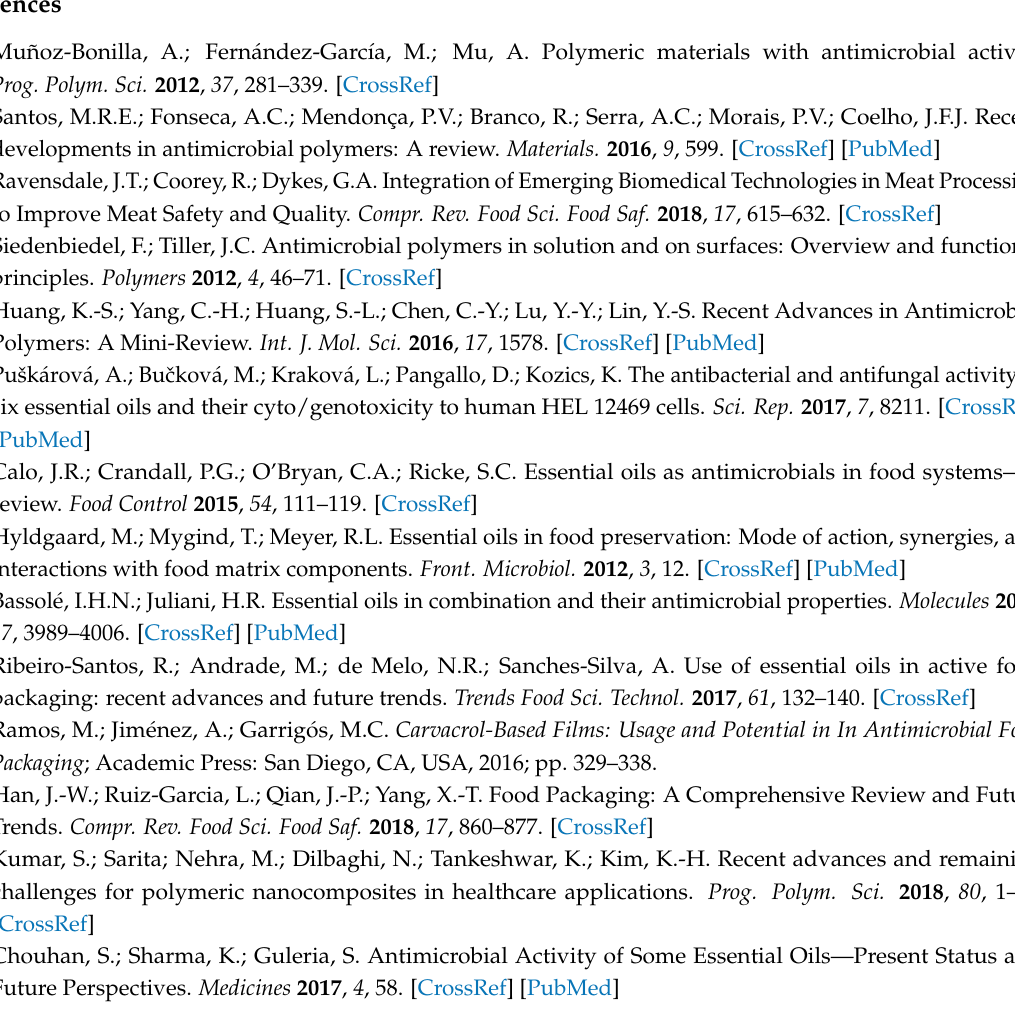
Figure S1: Characteristic images of the multilayered films prepared by forced-assembly layer-multiplying co-extrusion a) 9-layered (LDPE/carvacrol)/EVOH; b) 65-layered (LDPE/carvacrol)/EVOH; c) 9-layered (LDPE/[HNTs/carvacrol])/EVOH; and d) 65-layered